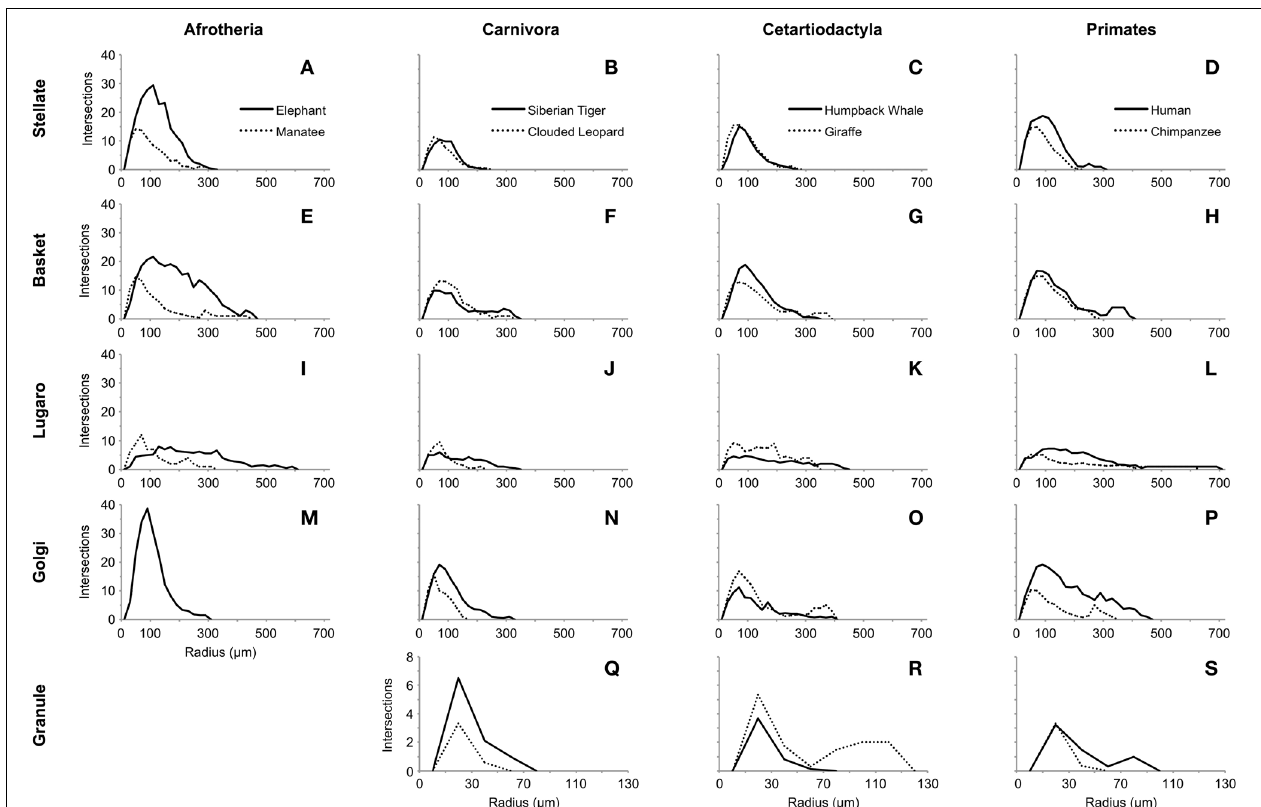
FIGURE 13 | Sholl analyses of five neuron types (stellate: A–D; basket: E–H; Lugaro: I–L; Golgi: M–P; granule: Q–S), arranged by taxonomic groupings (afrotherians: elephant and manatee; carnivores: tiger and clouded leopard; cetartiodactyls: humpback whale and giraffe; and primates: human and chimpanzee), indicating relative dendritic